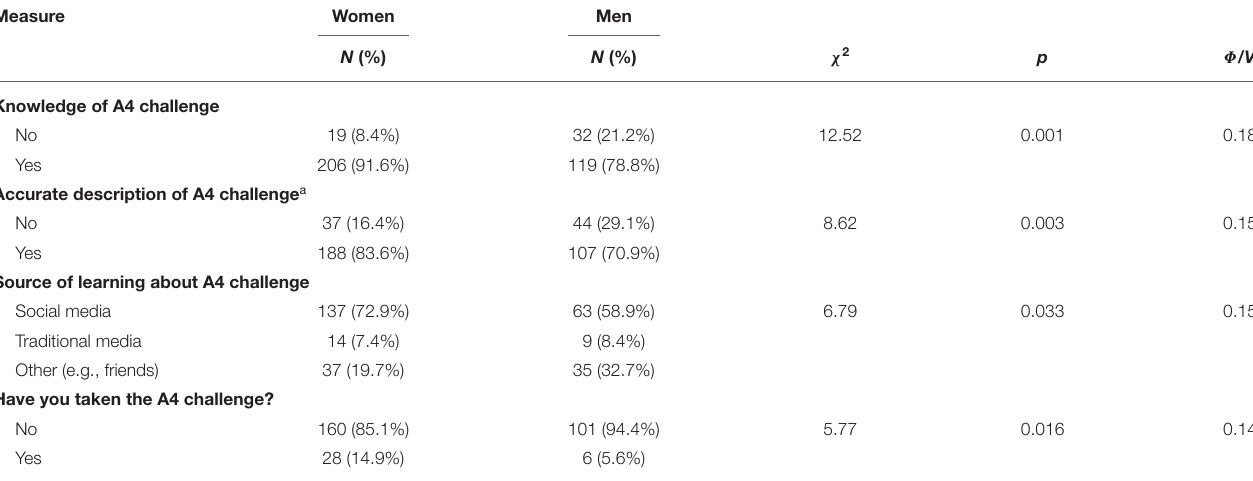
TABLE 1 | Gender differences on categorical measures of A4 challenge knowledge, experience, and perceptions ( N = 376).